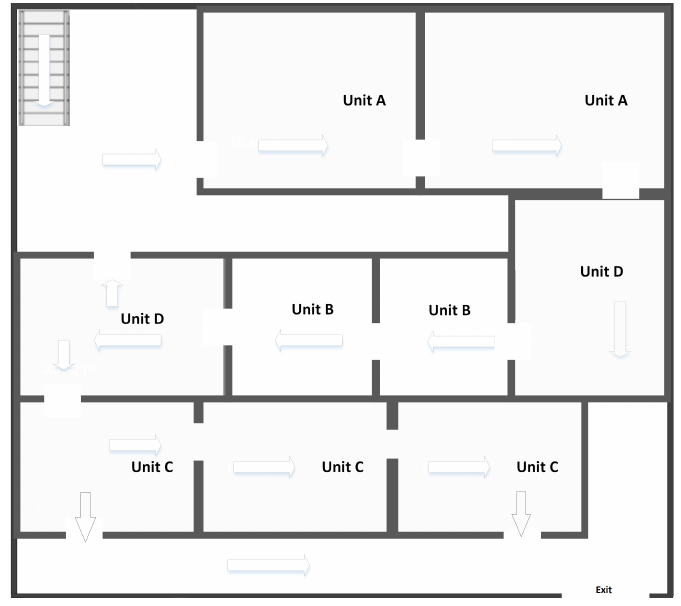
Figure 2. An example of indoor